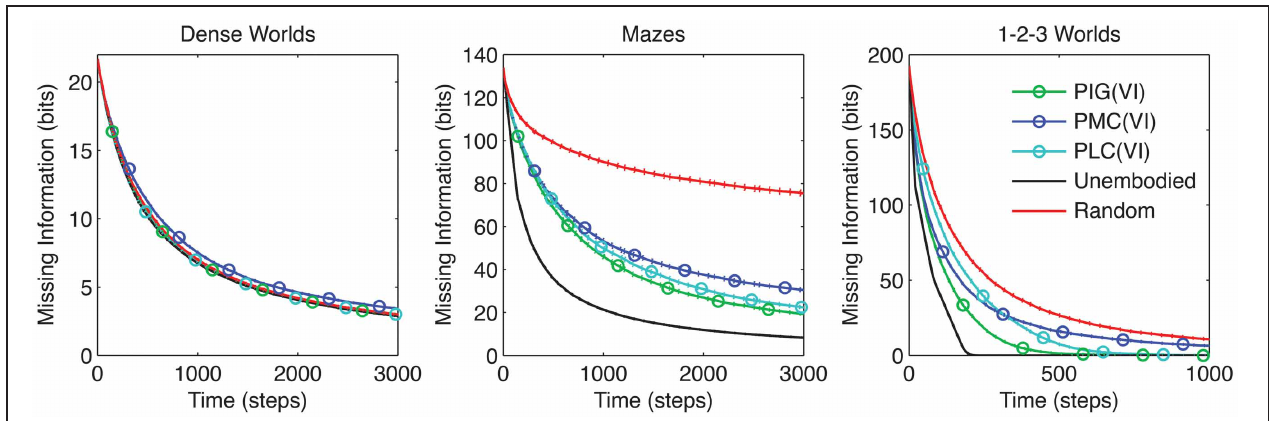
FIGURE 7 | Comparison between utility functions. The average missing information is plotted over time for agents that employ VI to maximize long-term gains in the three objective function, PIG, PMC, or PLC. The standard control strategies are also shown ( n = 200).